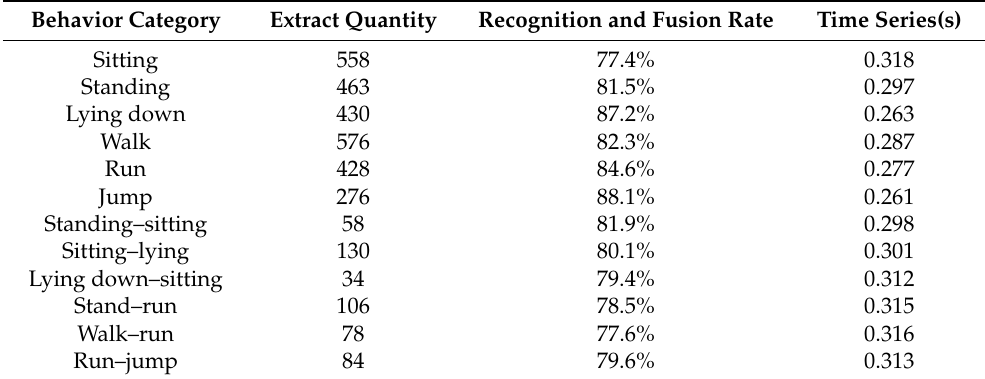
Table 6. Using wearable sensor feature